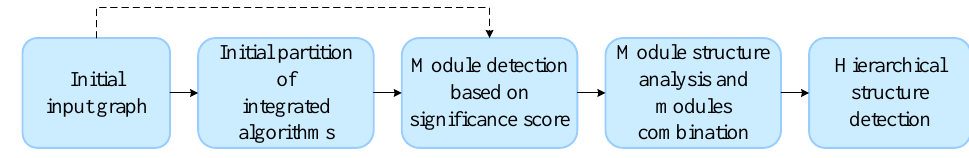
Figure 2. Workflow of